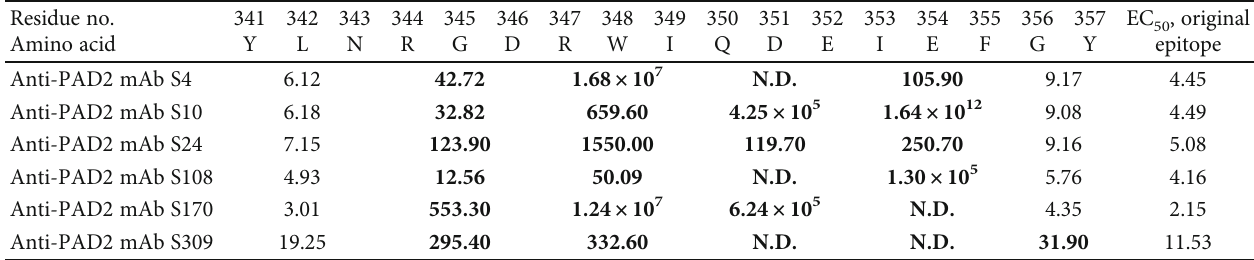
∗ Bold region showed no signi fi cant reactivity in alanine